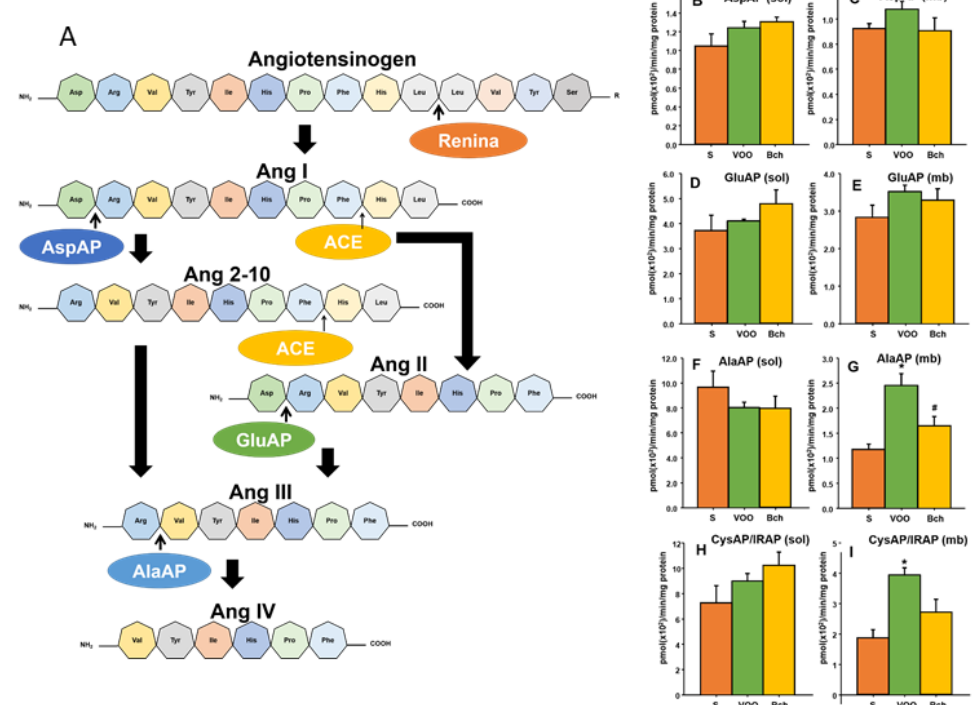
Figure 3. Partial representation of the renin–angiotensin system that shows the metabolic steps in which angiotensinase activities are involved ( A ); means values ± standard errors of aspartyl aminopeptidase activity (AspAP) in liver-soluble ( B ) and membrane-bound ( C ) fractions; glutamyl